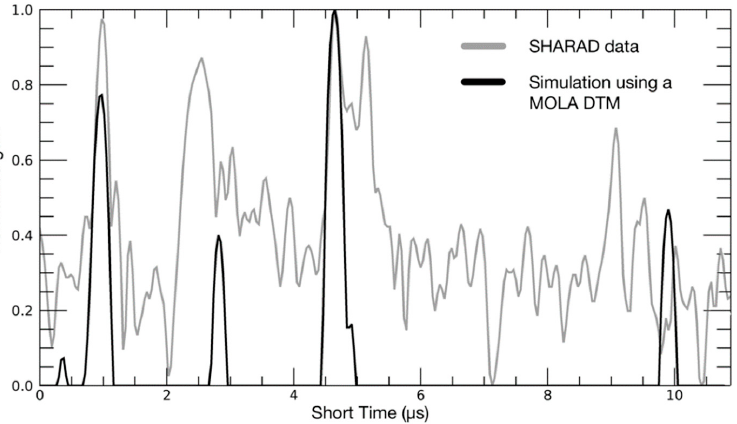
Figure 1. Single echo of SHARAD data compared to an echo of the simulation. The largest peaks of SHARAD data are well matched to the simulation.